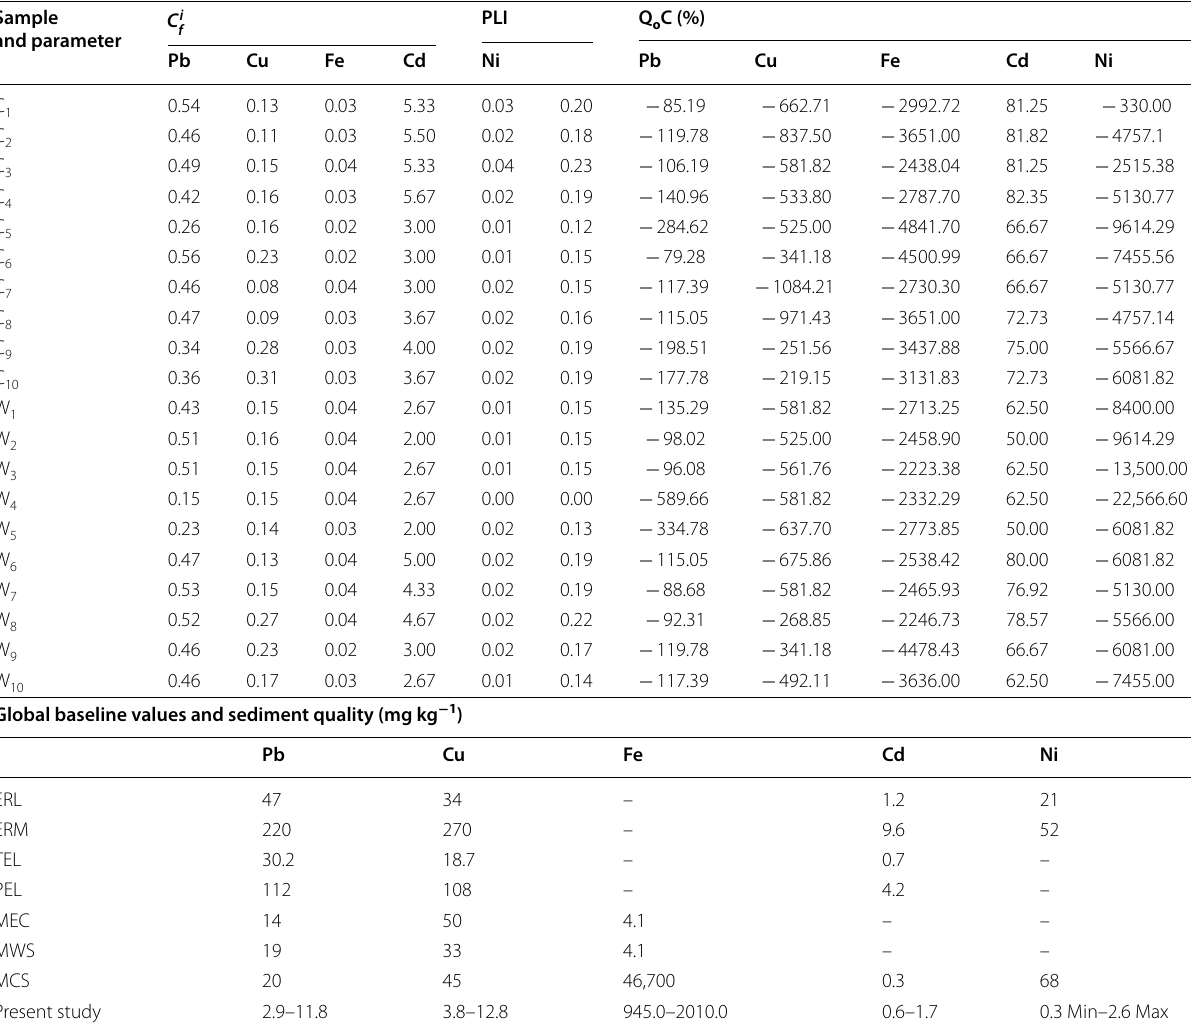
Table 4 Contamination factor, pollution load index, quantification of contamination and sediment quality guidelines Sample and